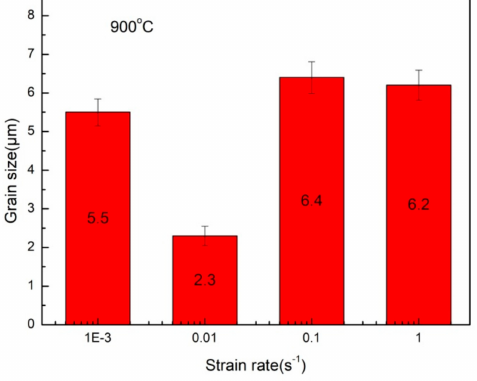
Figure 9. Variation of α grain size with strain rate at 900 ◦